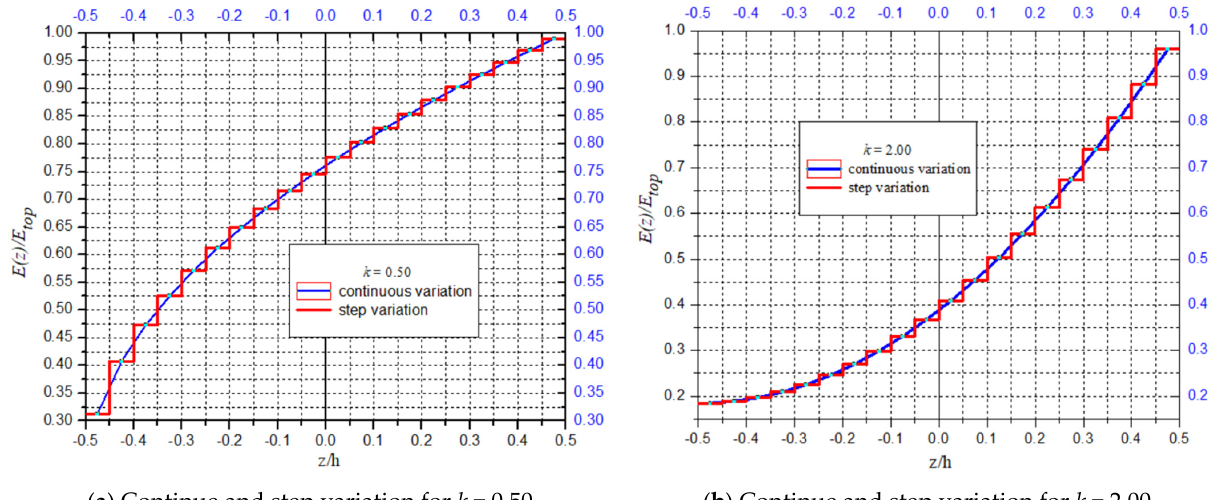
Figure 5. The step variation, compared to the continuous variation at the layer level, for two values of power coefficient k .